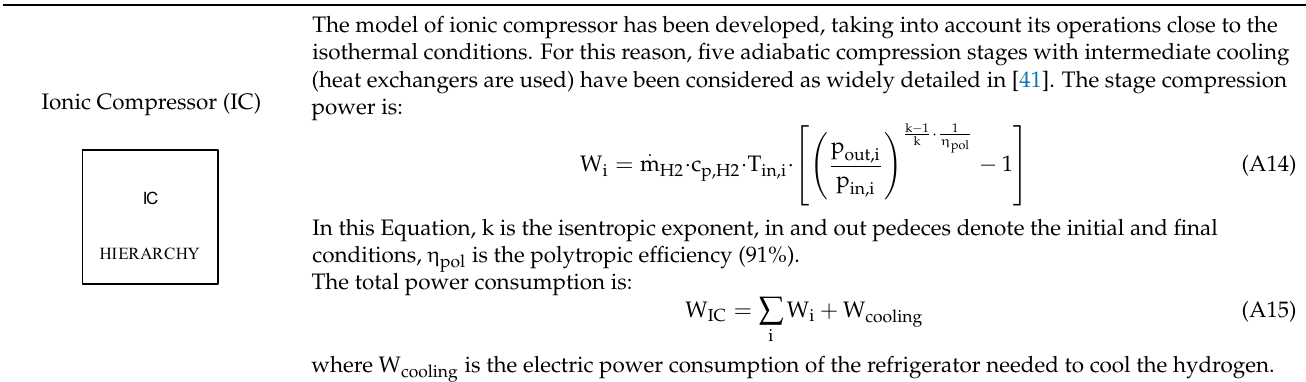
Table A3. Costs of the components used in the proposed